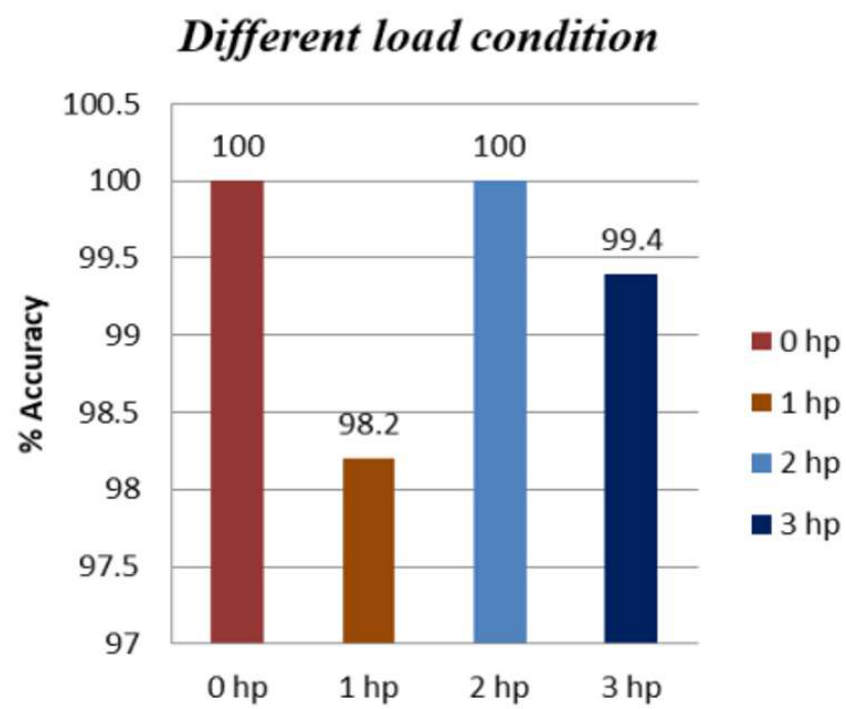
Figure 9. Performance under various load